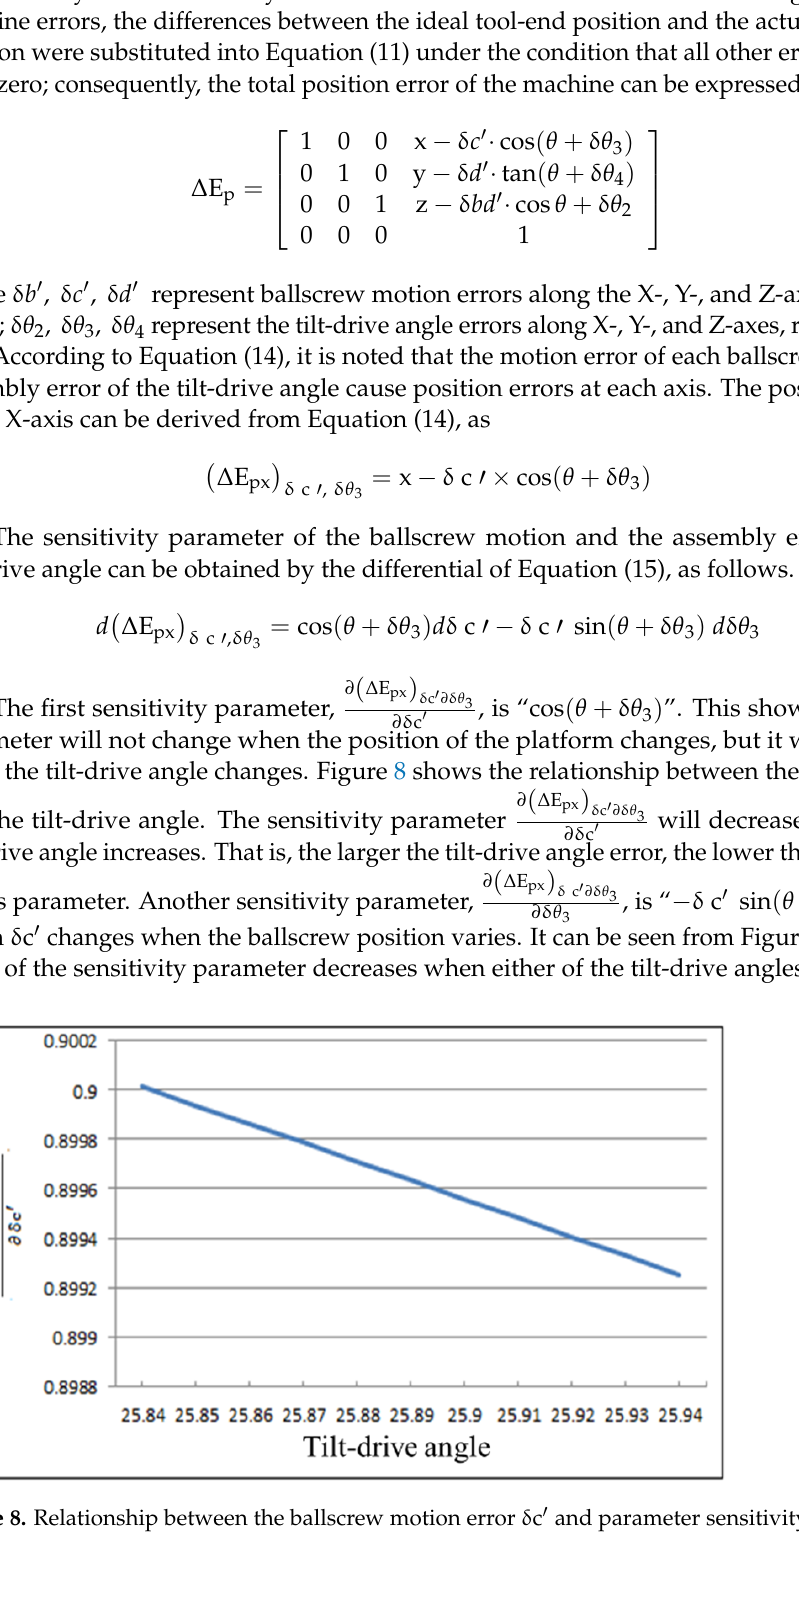
Figure 9. Relationship between the tilt-drive angle assembly error δθ 3 and parameter sensitivity. By substituting the condition of the prototype machine—where the tilt-drive angle θ is 25.84 ° , the assembly error of the tilt-drive angle δθ 3 is 0.05 ° , and the ballscrew motion error is 0.5 μ m—into Equation (17), it is found that machine accuracy can be controlled within a range of 1 μ m. Additionally, it can be concluded that the ballscrew motion error source has a greater impact on the overall X-axis error. Similarly, the error source of the Z-axis ballscrew motion has a greater impact on the overall Z-axis error. |cos(θ + δθ (cid:2871) )| |δc (cid:4593) sin (θ + δθ (cid:2871) )| (cid:3408) 1 (17) The position error of the Y-axis can be calculated using Equation (18). The sensitivity parameter of the ballscrew motion and the assembly error of the tilt-drive angle can be obtained by means of the differential of Equation (18), as follows.